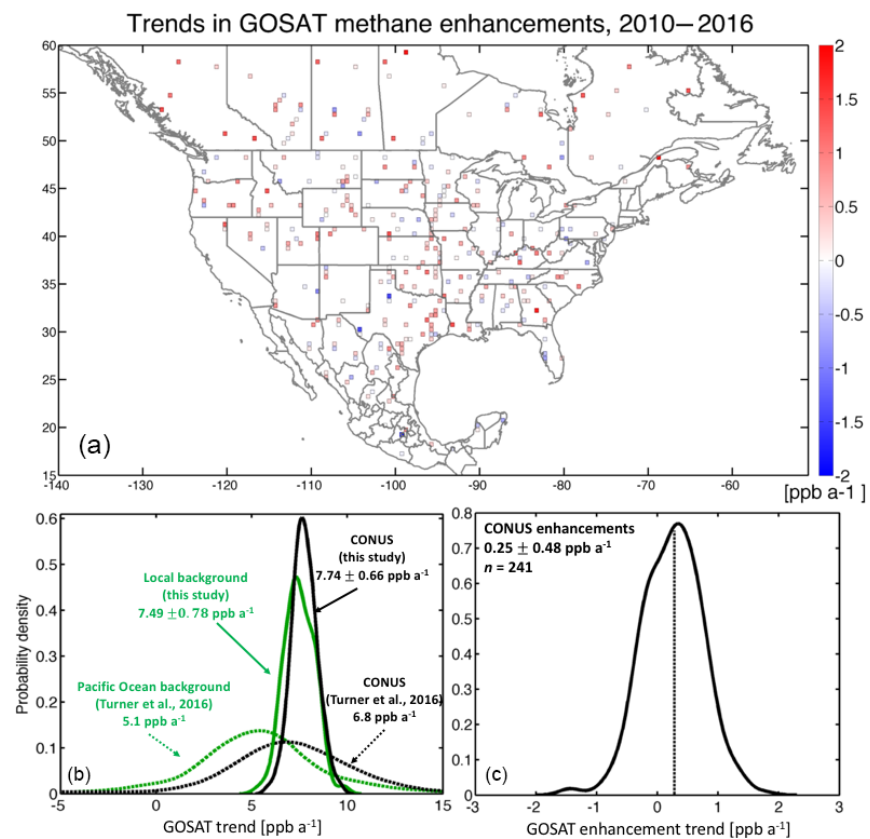
Figure 2. The 2010–2016 trends in GOSAT methane enhancements over North America. (a) Ordinary least-squares linear regression trends for 0 . 5 ◦ × 0 . 5 ◦ grid cells with sufficient GOSAT observations, where the deseasonalized annual mean methane enhancements are defined relative to a local low-percentile background as described in the text. The trends are not statistically significant at that resolution (see text). (b, c) Spatial frequency distributions for the 0 . 5 ◦ × 0 . 5 ◦ grid cells over the contiguous United States (CONUS) of mean methane and local background (b) , and local methane enhancements computed by difference (c) . The dashed black line in the lower-right panel indicates the mean trend in CONUS enhancements. Also shown in the lower-left panel are the 2010–2013 trend distributions from Turner et al.